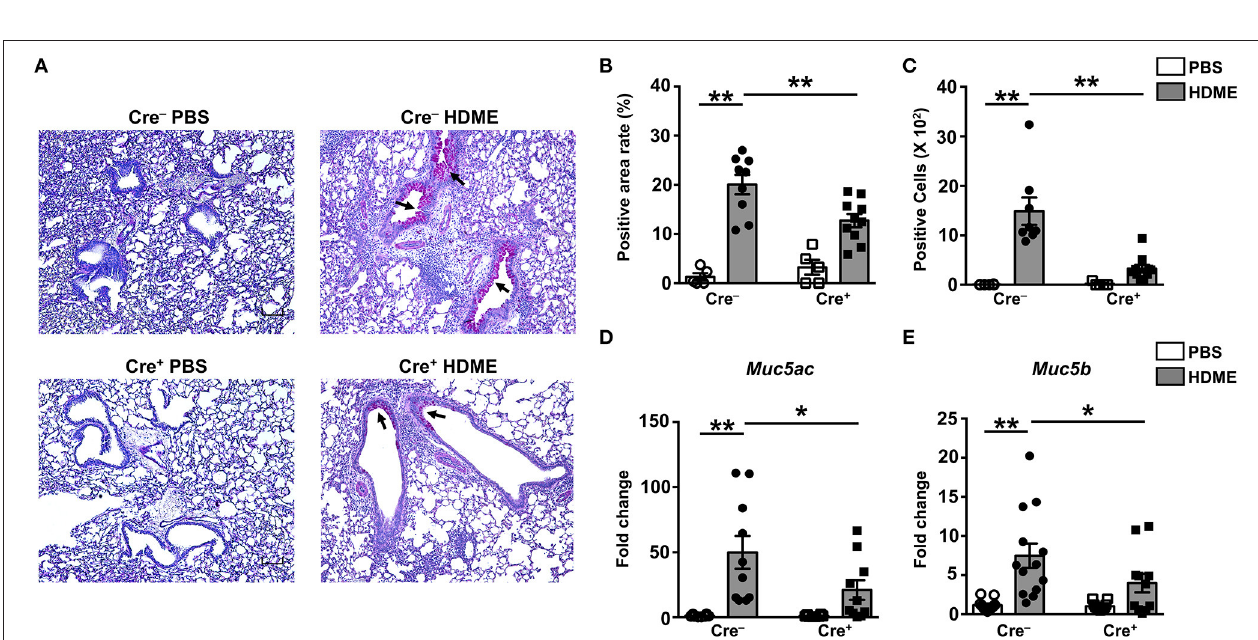
FIGURE 7 | Decreased goblet cell hyperplasia and mucin production in the lungs of HDME-challenged mice that lack GRK2 in T cells. Cre − and Cre + mice were challenged with PBS or HDME. Twenty-four hours after the last injection of HDME, mice were sacrificed, and lung tissues were analyzed for (A–C) PAS staining and (D,E) mRNA expression of polymeric mucins [ (D) Muc5ac and (E) Muc5b ]. Representative lung images [ (A) , 4 × magnification, arrows indicate PAS staining] and (B) % PAS positive area and (C) PAS positive cell counts are shown. Scale bar = 100 µ m. Data in (B–E) are presented as mean ± SEM and are pooled from 2 to 3 independent experiments with a total of 5–14 male and female mice per cohort. Statistical significance was determined using Student’s unpaired t -test. * p ≤ 0.05, ** p ≤ 0.01.